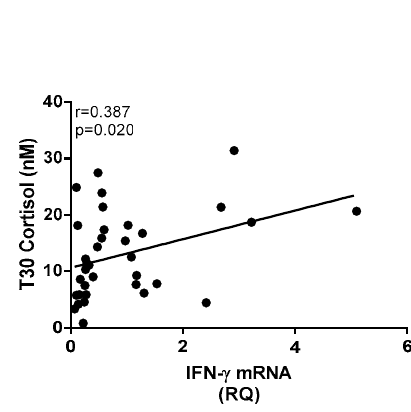
Figure 8. Correlational analysis between mRNA expression of cytokines and HPA axis measures in depressed patients. A Spearman’s rho correlation revealed ( a ) a significant negative correlation between mRNA expression of IL-1 β and morning cortisol reactivity within the depressed group and ( b ) a significant positive correlation between mRNA expression of IFN- γ and T30 cortisol concentration within the depressed group.